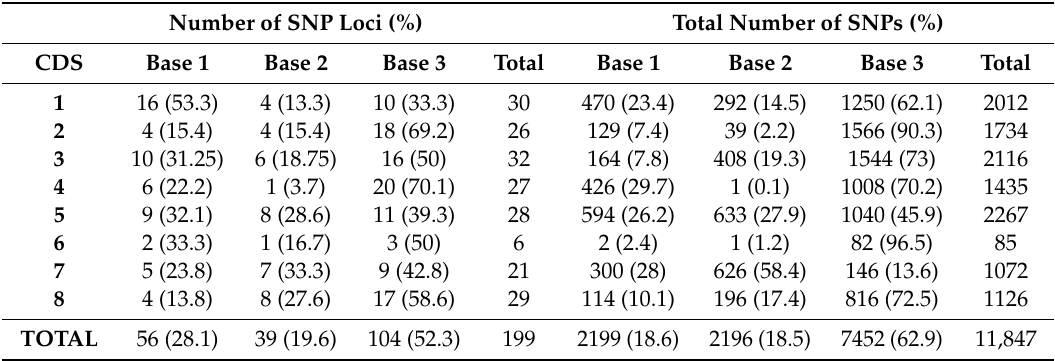
Table 4. SNP loci and total number of SNPs in relation to position within the codon. Percentage of bases at that position are shown in parentheses. Number of SNP Loci (%) Total Number of SNPs